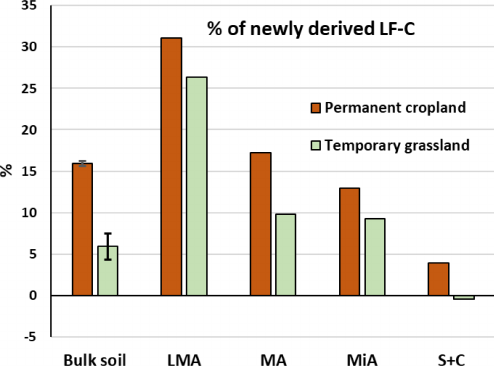
Figure 3. Percentage of maize-derived (C4) light fraction carbon (LF-C) for bulk soils and aggregate fractions under permanent crop- land and ley grassland. Note: LMA – larger macroaggregate; MA – macroaggregate; MiA – microaggregate; and S + C – silt and clay. Values of S + C for ley grassland were slightly lower ( − 0 . 4%) than those found for permanent grassland, probably due to field variabil- ity. Error bars show the calculated standard deviations for replicate